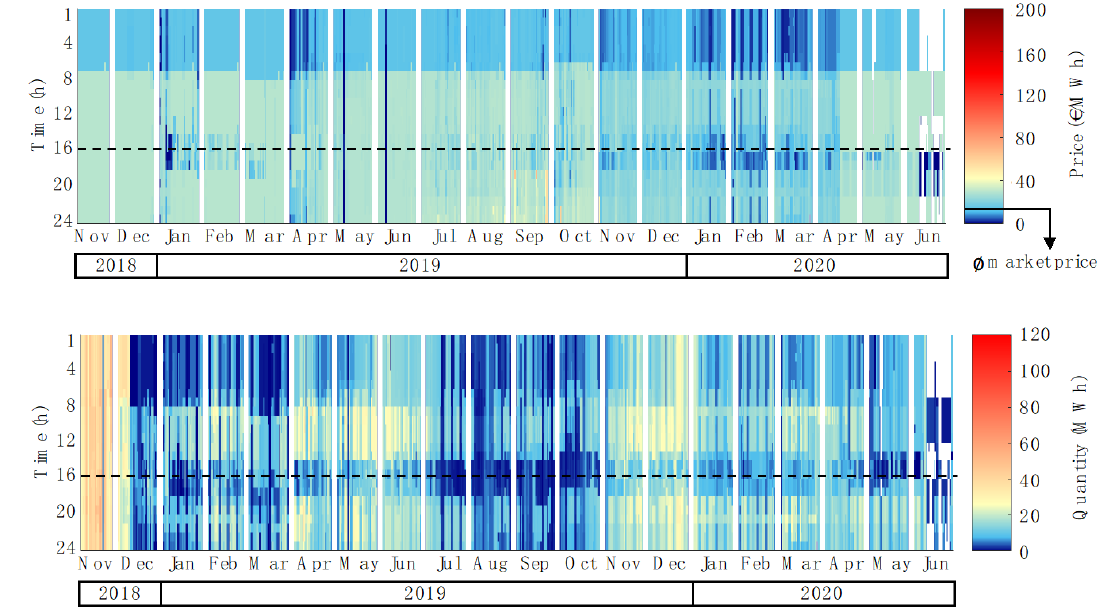
Figure A1. Heatmap of downward bids by UVAMs in terms of weighted average offered price (chart above ) and summed offered quantity (chart below ) with hourly resolution in the timeframe November 2018 to February 2020.